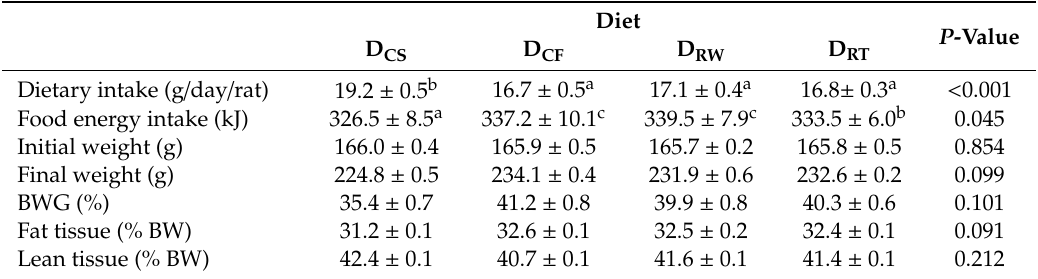
Table 3. Dietary intake, body weight gain, and body fat / lean tissue of rats fed experimental diets. Data are expressed as mean ± SEM, n =